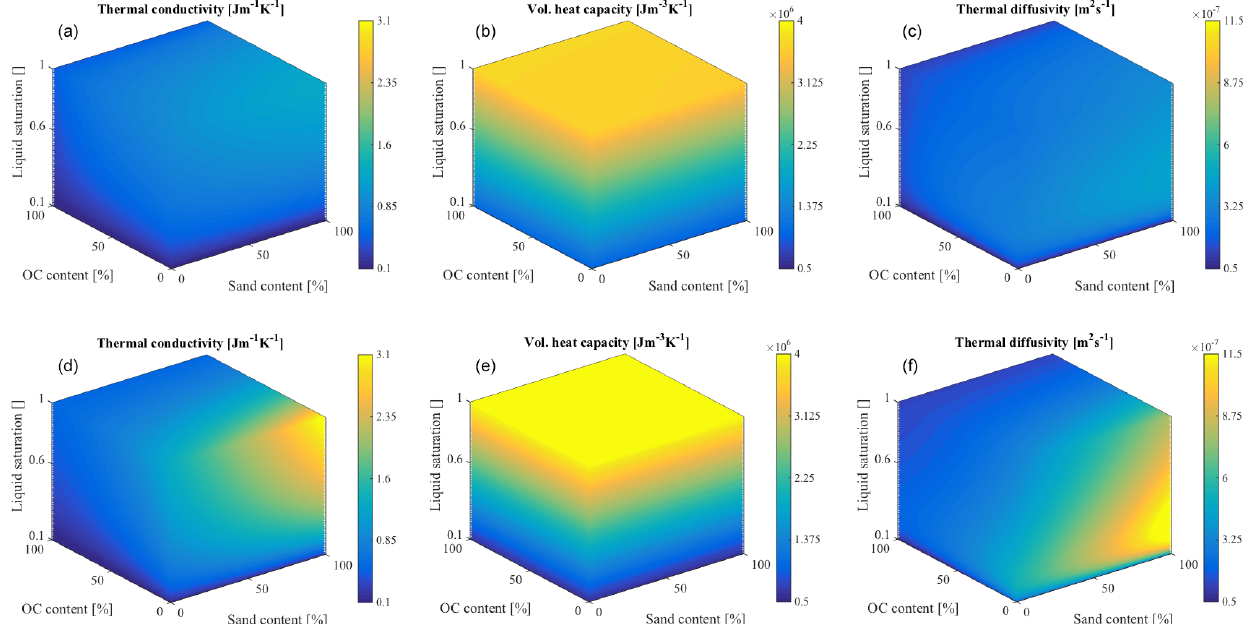
Figure 2. Soil thermal conductivity (a, d) , heat capacity (b, e) and thermal diffusivity (c, f) as a function of the liquid water saturation, OC and sand content. The calculation for this figure was based on equations presented in Appendix A. The soil porosity was fixed at 0.7 for (a) – (c) and determined as a function of OC and sand content (Eqs. 2 and 3) for (d) – (f) . (a) Thermal conductivity; porosity φ = 0 . 7. (b) Volumetric heat capacity; porosity φ = 0 . 7. (c) Thermal diffusivity; porosity φ = 0 . 7. (d) Thermal conductivity; porosity is a function of OC and sand content. (e) Volumetric heat capacity; porosity is a function of OC and sand content. (f) Thermal diffusivity; porosity is a function of OC and sand